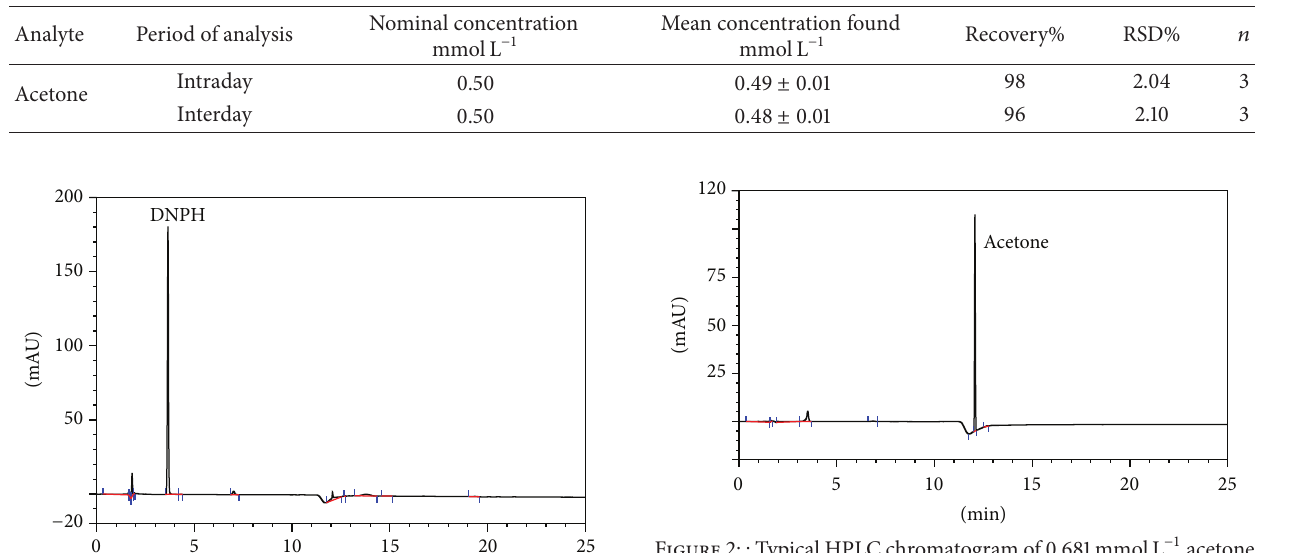
Figure 2: : Typical HPLC chromatogram of 0.681 mmolL −1 acetone as its 2,4-DNPH derivative; for chromatographic conditions: see Section 2.